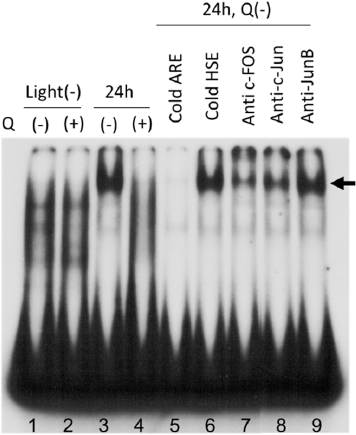
Figure 7. The electrophoretic mobility shift assay (EMSA). Nuclear proteins in the neural retinas from quercetin (+) or saline-treated rats are probed with a radio-labeled AP-1 sequence. Samples from rats